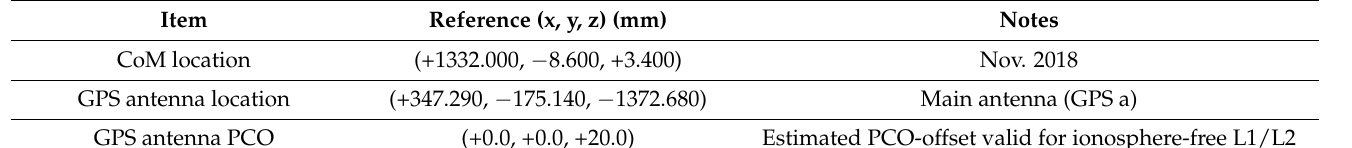
Table 4. Coordinates for the GPS receiver and CoM in the body-fixed coordinate system.